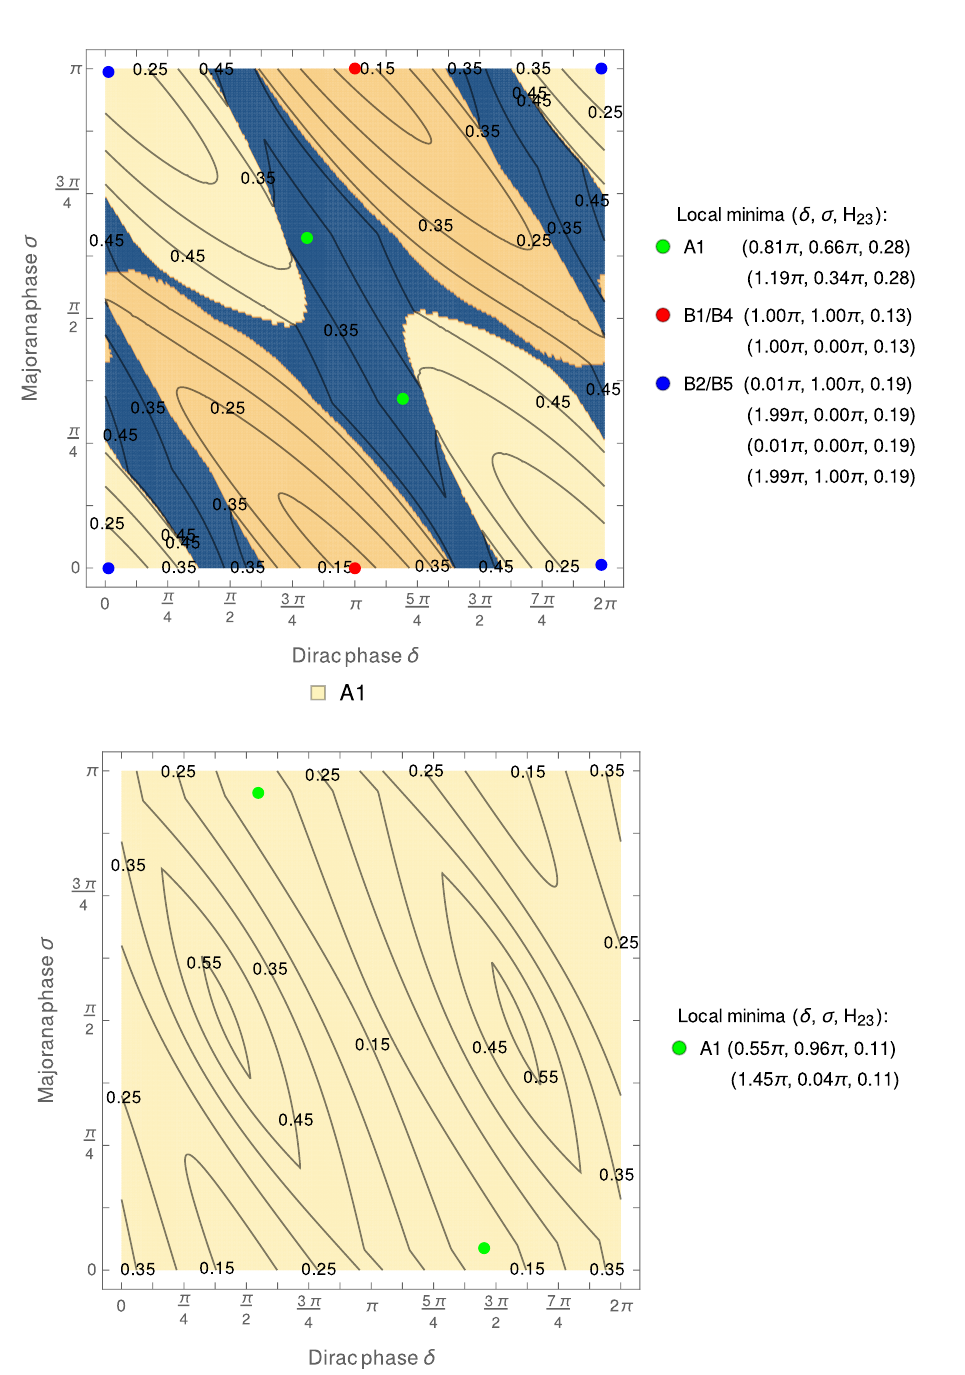
Figure 3 . Minimized hierarchy parameter H 23 as a function of the CP -violating phases (cid:14) and (cid:27) for normal mass ordering , see eq. (4.1). The upper panel displays the results of minimizing R 23 only over values of j z I j of O (1) (no (cid:13)avor alignment), while in the lower panel , we plot the asymptotic (cid:8) (cid:9) value min R (cid:0) ; R + at j z I j (cid:29) 1 ((cid:13)avor alignment), see eq. (3.13). Contour lines, color shading, 23 23 colored points, and plot legends as in (cid:12)gure 2.